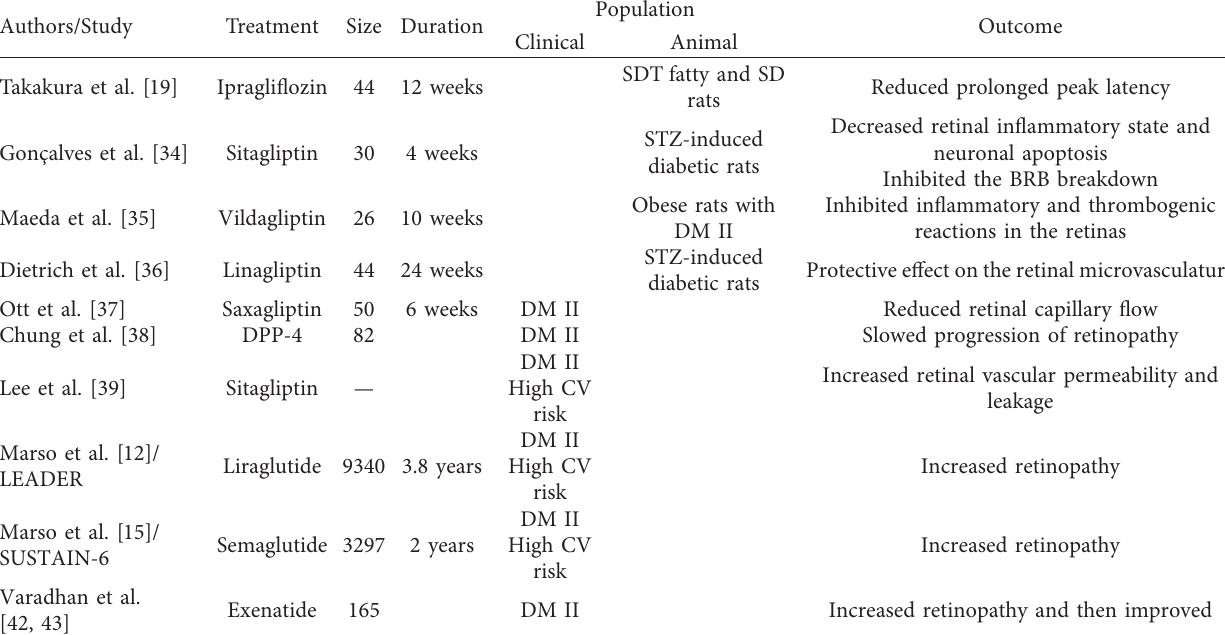
Table 3: Overview of the ophthalmological protective